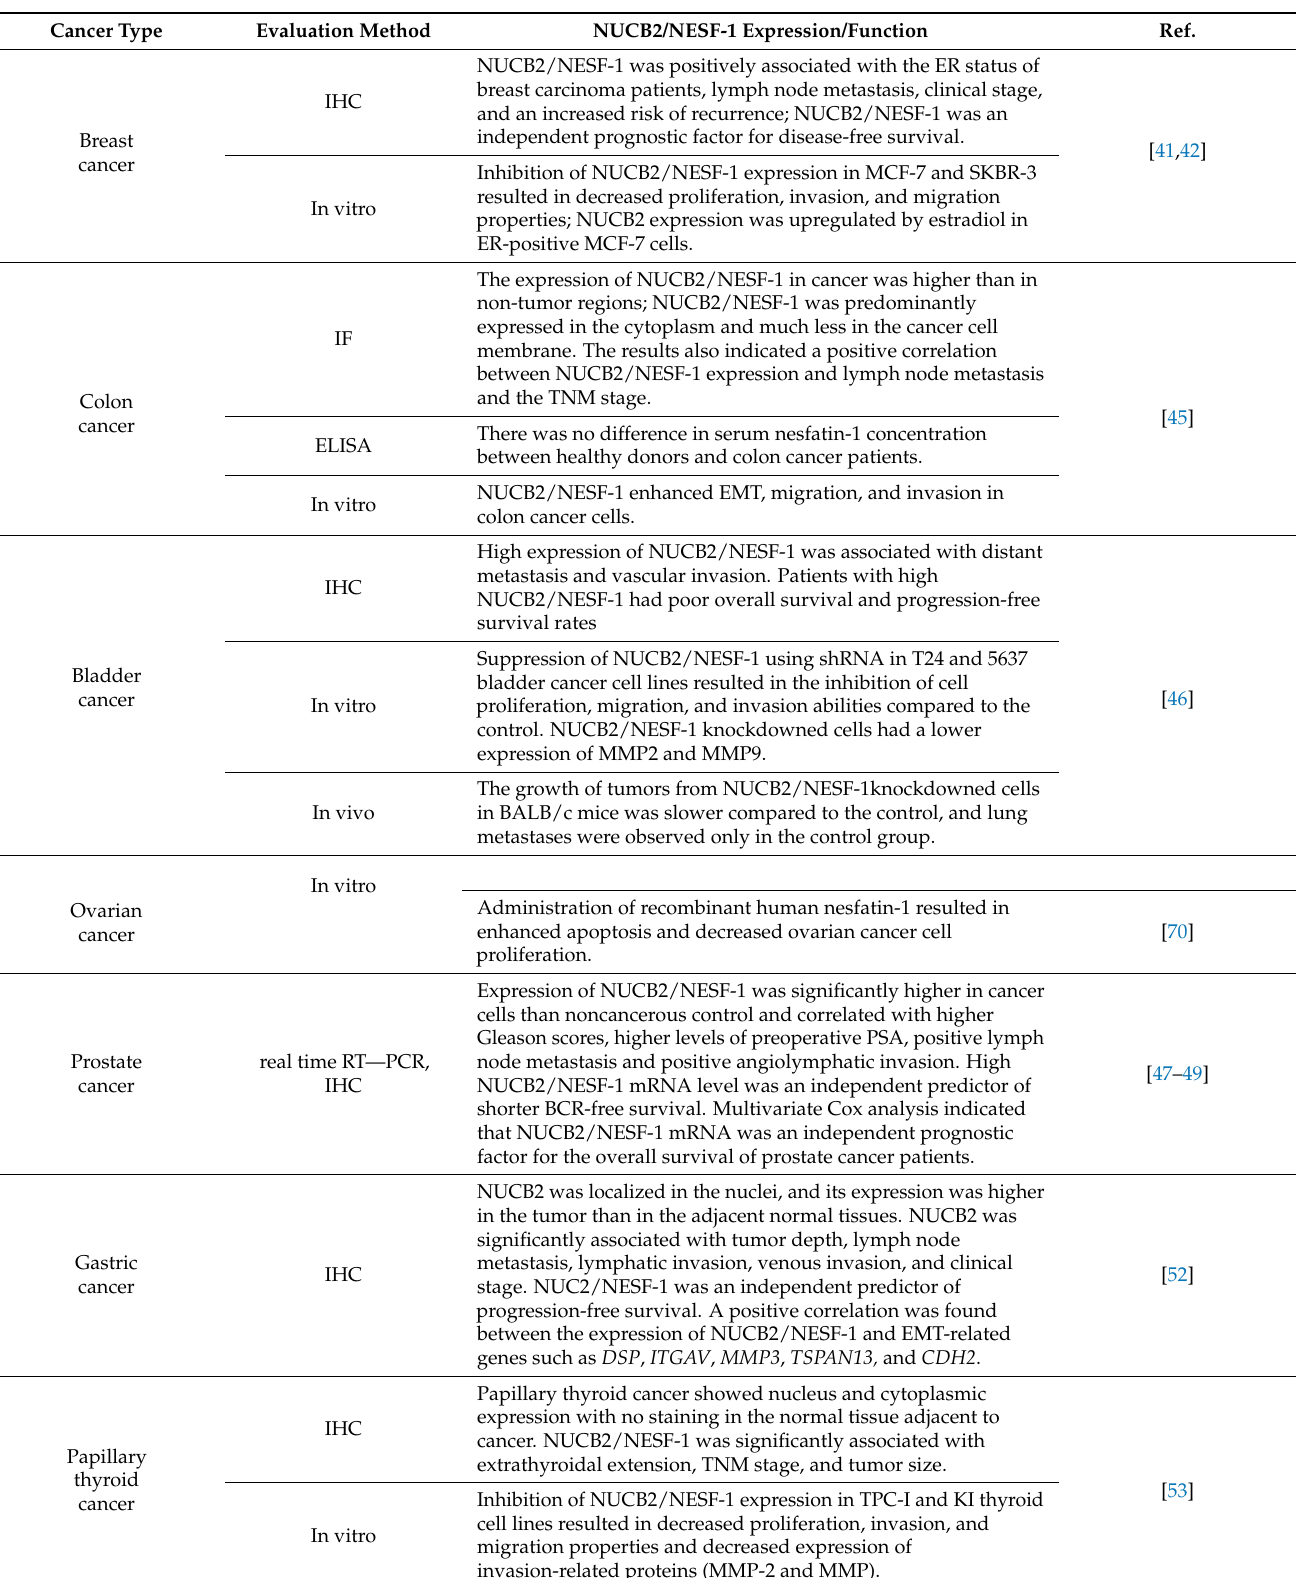
Table 1. Expression and function of NUCB2/NESF-1 in different cancer